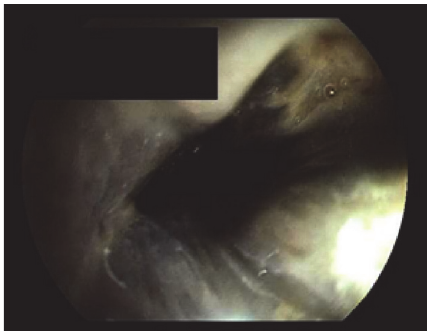
Figure 2: Endoscopic image of proximal esophagus showing cir- cumferentially black mucosa.